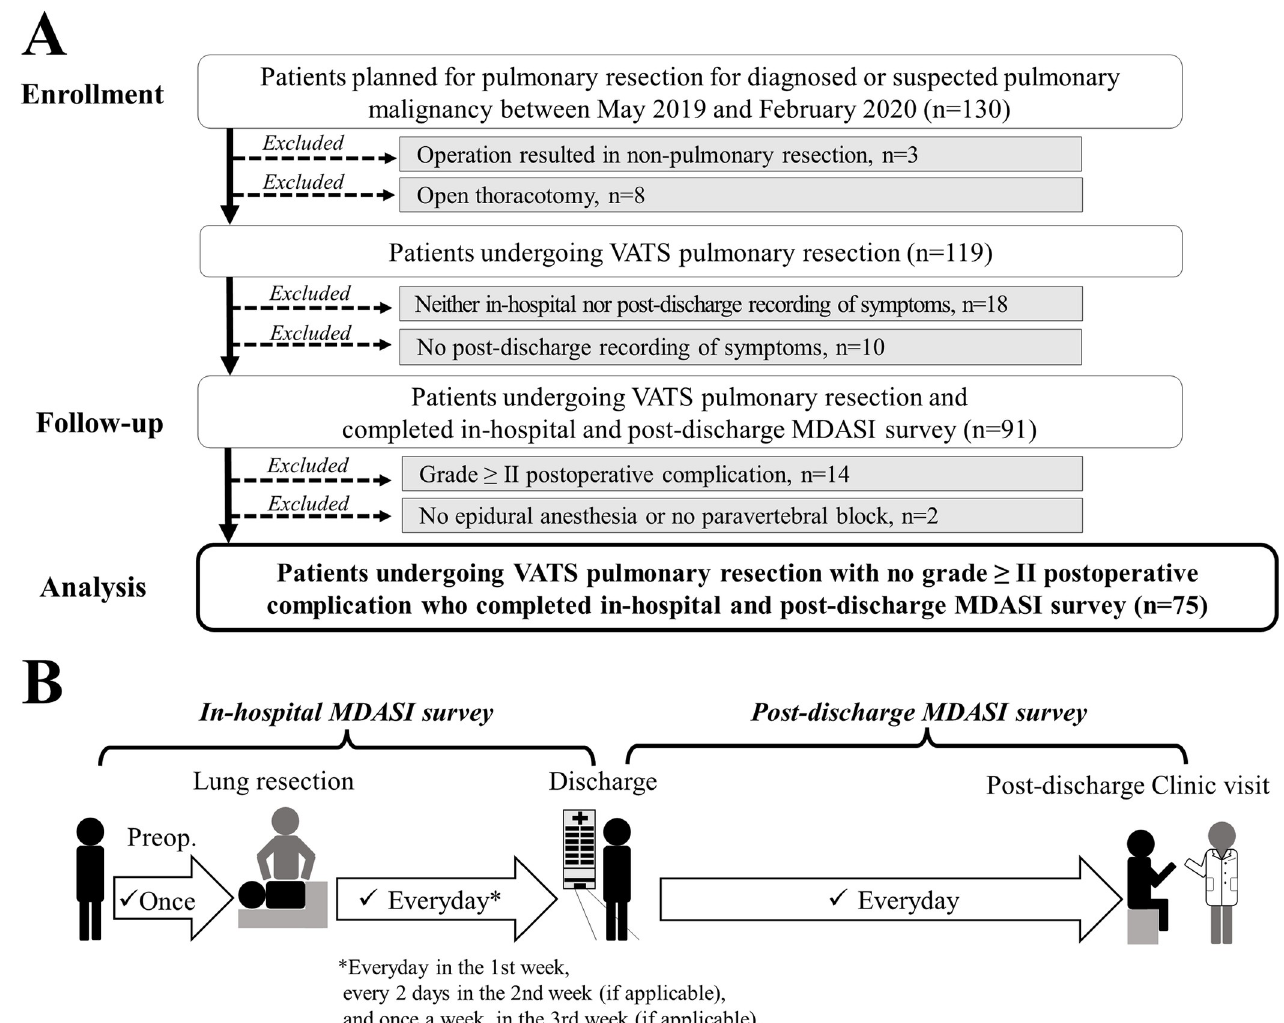
Fig 1. CONSORT flow diagram of the study population and schedule for symptom severity recording. A: Flow diagram depicting the selection process of participants eligible for data analysis. B: The in-hospital recording of symptom severity/interference was scheduled once preoperatively; once daily during the first postoperative week; and if applicable, every 2 days during the second postoperative week and once a week during the third postoperative week. The post- discharge recording of symptom severity/interference was scheduled daily until the first outpatient clinic visit. MDASI: MD Anderson Symptom Inventory; VATS: Video-assisted thoracoscopic